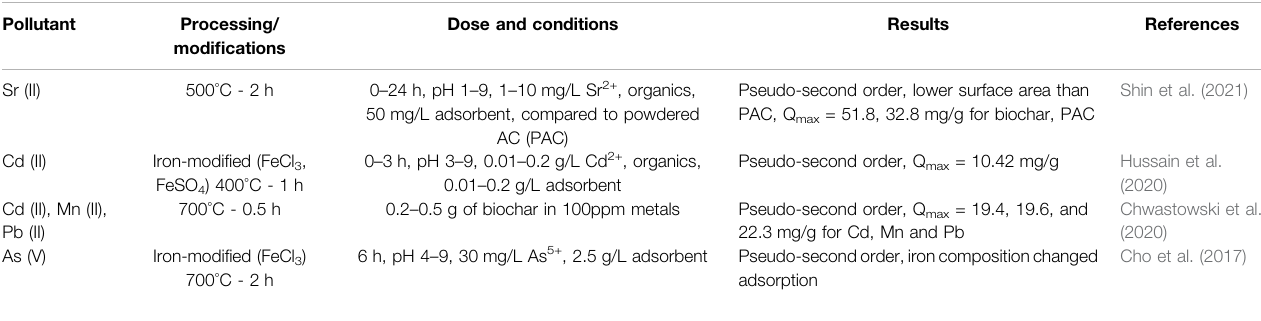
TABLE 6 | Recent studies on metal adsorption using SCG derived biochar.